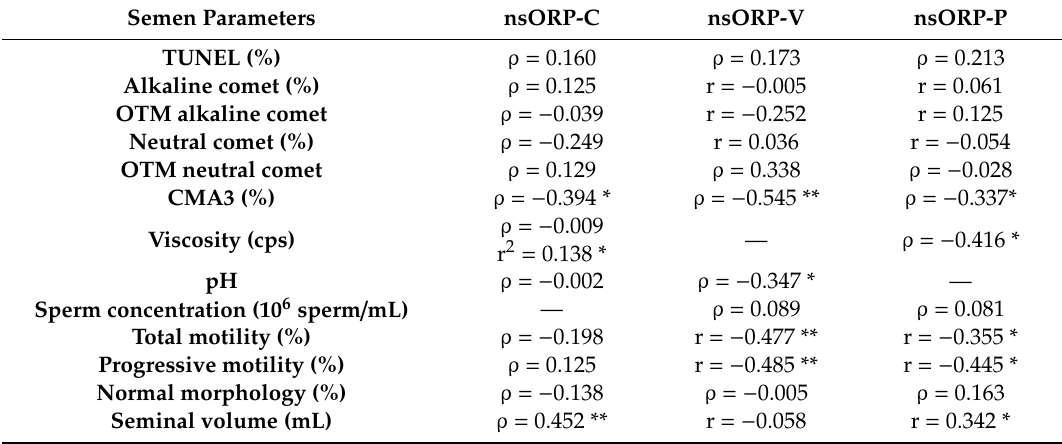
Table 3. sORP correlation analysis with semen and sperm parameters with Pearson’s (r) and Spearman’s ( ρ ) correlation test as it matches. Confirmation with an inverse curvilinear estimation (r2) in the required